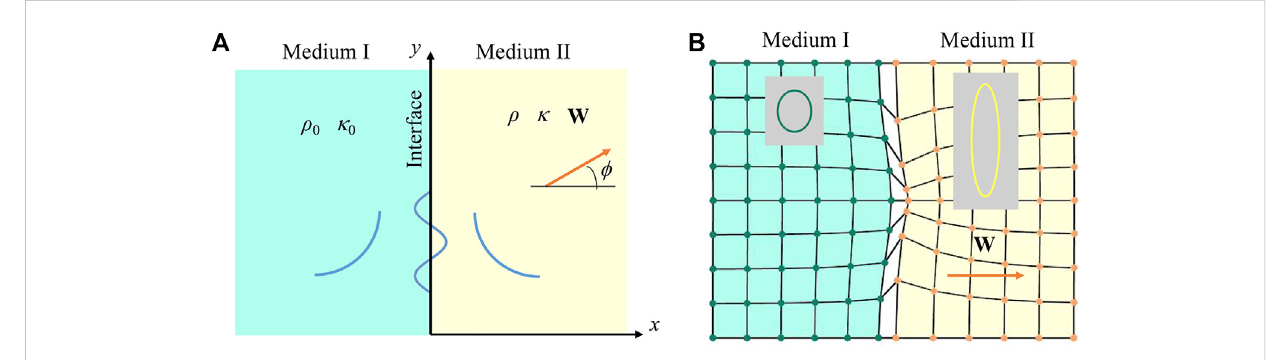
FIGURE 6 (A) Schematicrepresentationoftheinterfacemodebetweenanordinarymedium(MediumI)andaWillismedium(MediumII).Theinterfacemodeis a traveling mode along thesurface and evanescent away from theinterface. (B) Wave mode of the interface wave, where the interface expands at a fi nite width to clearly display the particle motion on both sides. The insets show typical particle orbits on each